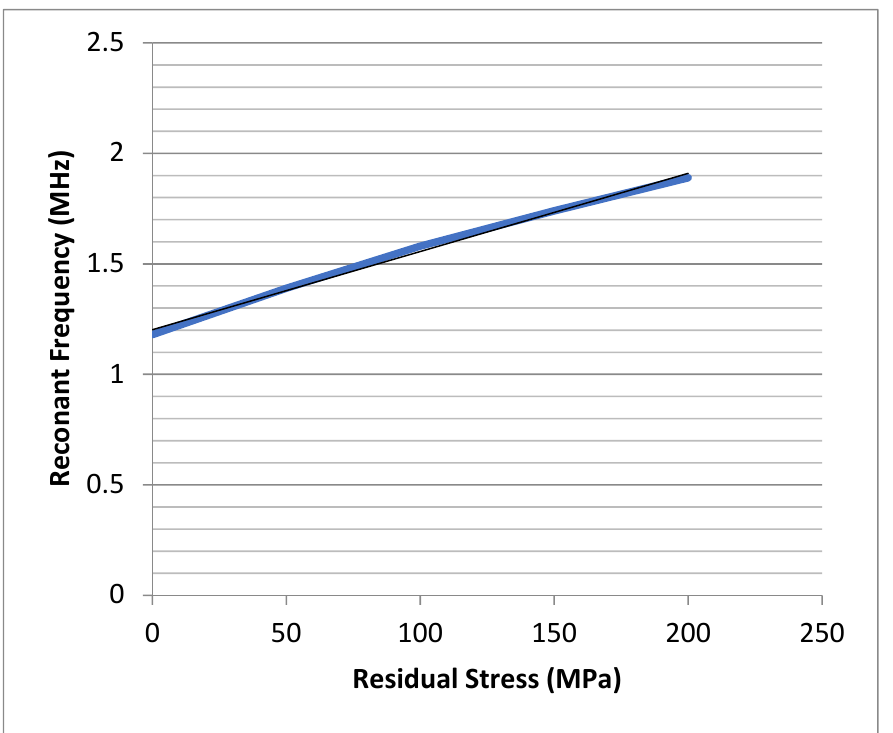
Figure 4. Plot of Resonant Frequency (MHz) verses Residual Stress (MPa) in a Beam Resonator.